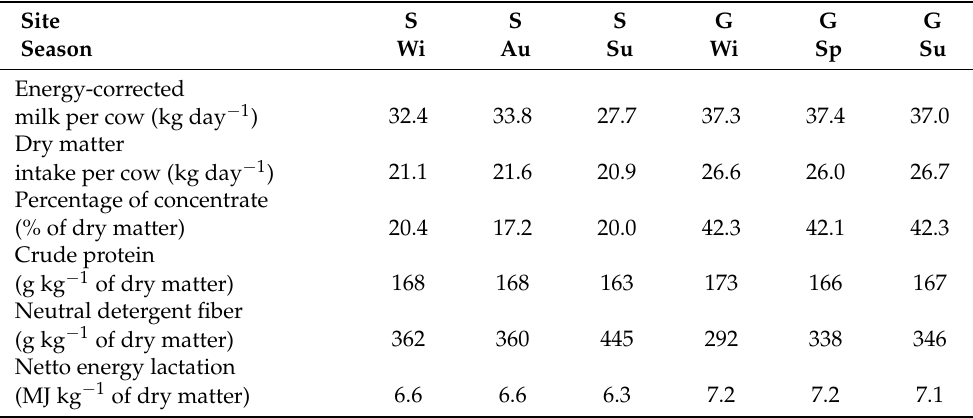
Table 1. Milk yield and feed composition for each site (i.e., S = Switzerland, G = Germany) and the different seasons (i.e., Wi = winter, Sp = spring, Su = summer and Au = autumn). Site S S S G G G Season Wi Au Su Wi Sp Su Energy-corrected milk per cow (kg day − 1 ) 32.4